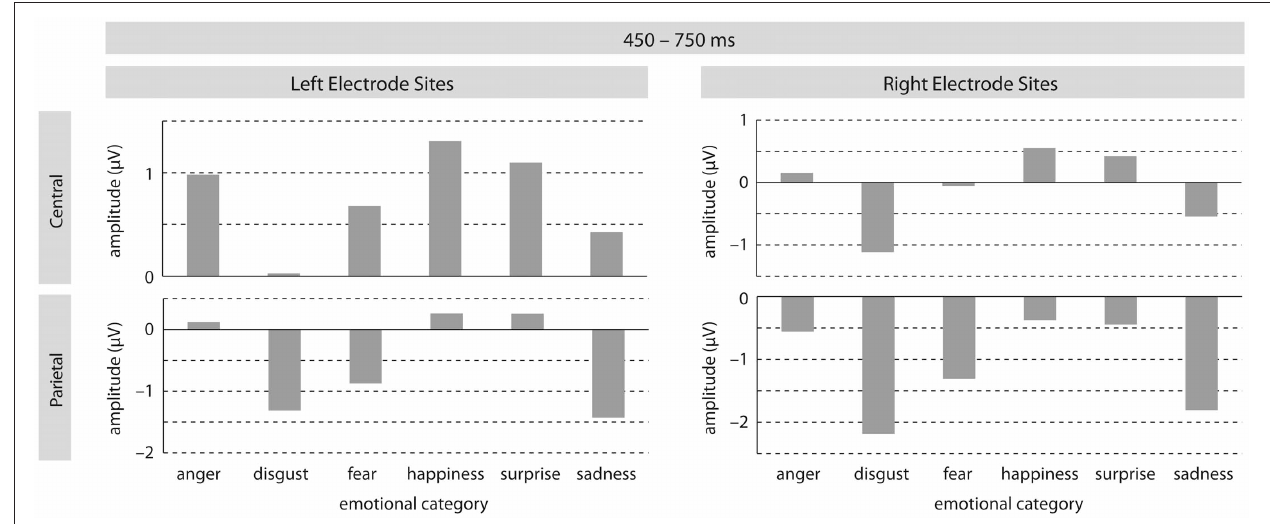
FIGURE 2 | The illustration showsmean LPC amplitudes(inmV) for each emotional category at left/right central and left/right parietal electrode-sites.